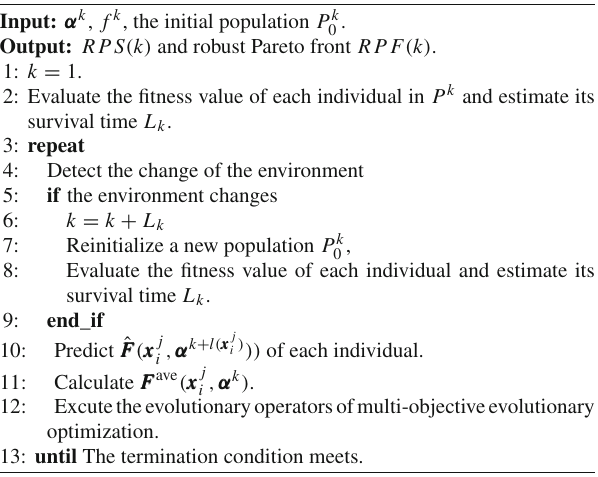
Algorithm 2 RPOOT-based dynamic multi-objective opti- mization